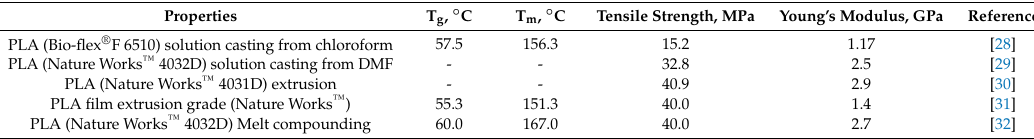
Table 1. Mechanical and thermal properties of